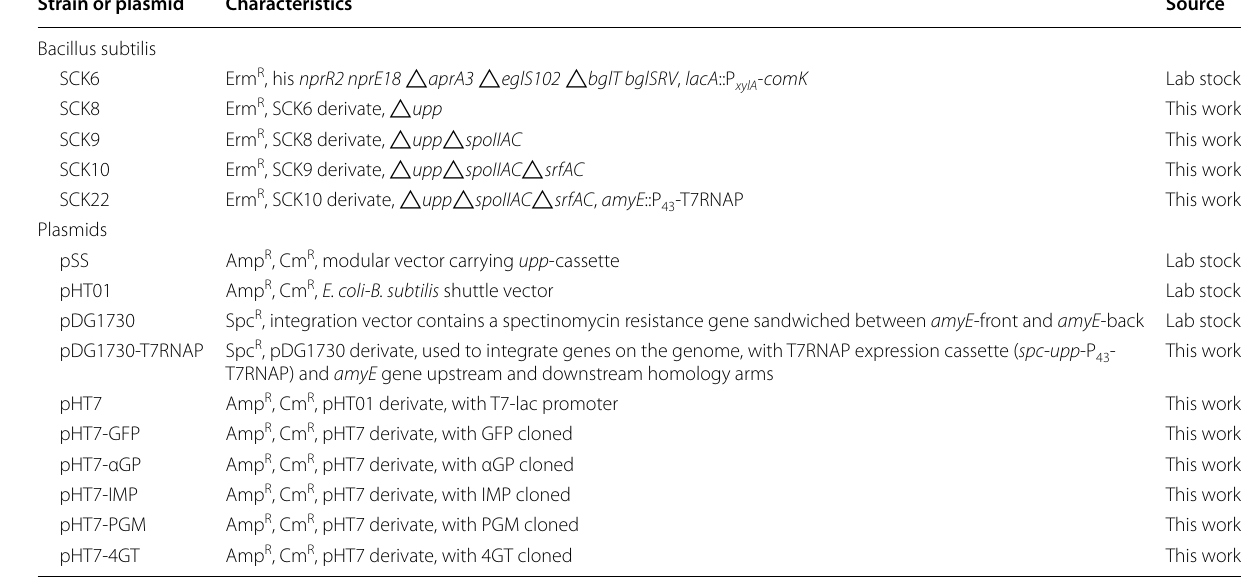
Table 2 Bacterial strains and plasmids Strain or plasmid Characteristics